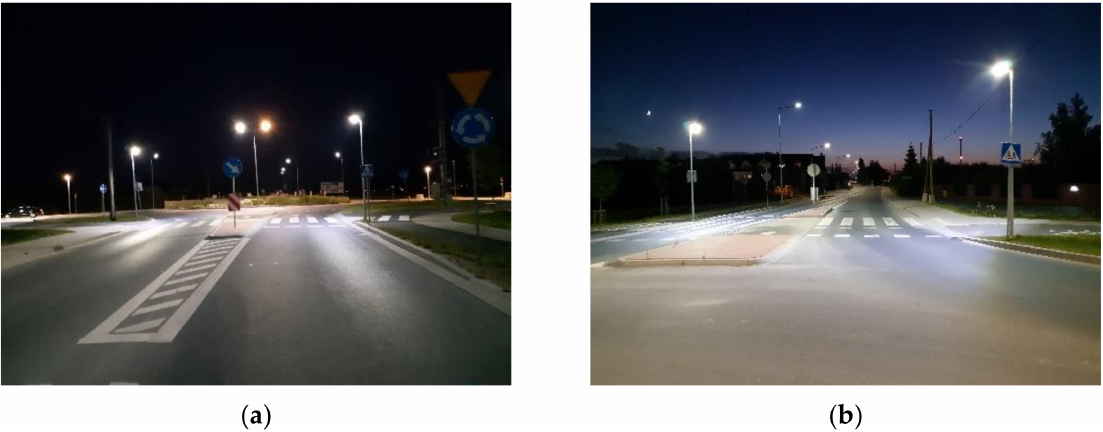
Figure 11. Night-time appearance of pedestrian crossing no. 3 with the bike path ( a ) view towards the roundabout, ( b ) view away from the